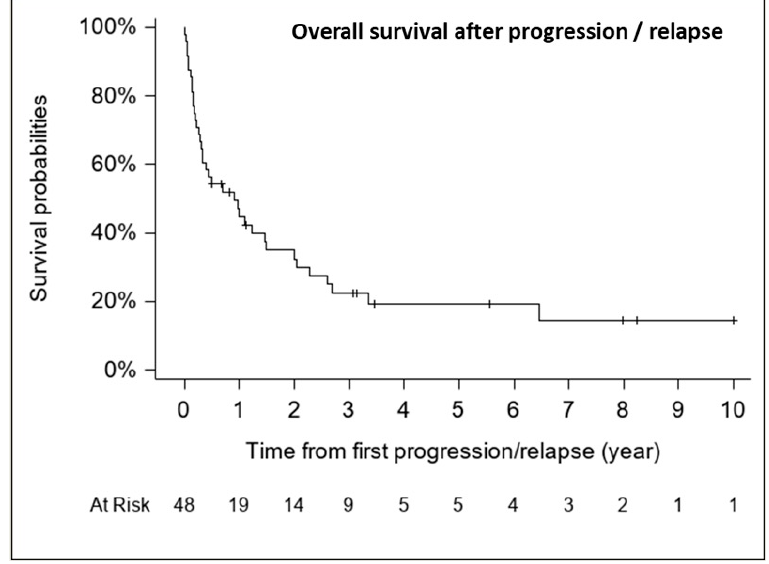
Figure 7. Overall survival after progression/relapse (n = 48, 37 deaths).